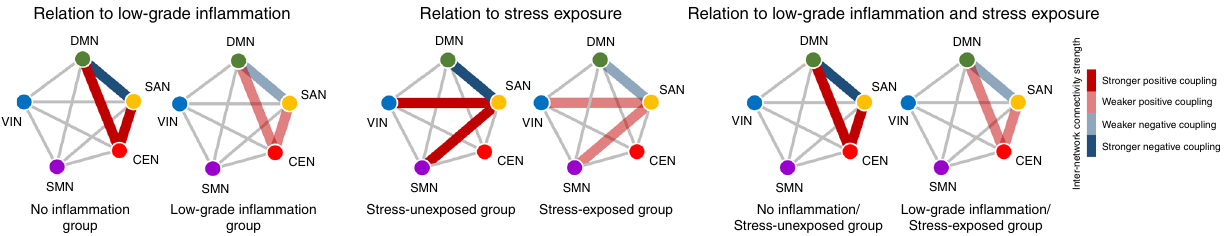
Fig. 5 Schematic representation of the alterations in inter-network connectivity strength in relation to low-grade in fl ammation (left), stress exposure (middle), and the presence of both conditions (right). Red and blue lines of the schematic diagram for inter-network clusters indicate the positive and negative coupling of networks, respectively. DMN default mode network, SAN salience network, CEN central executive network, SMN sensorimotor network, VIN visual